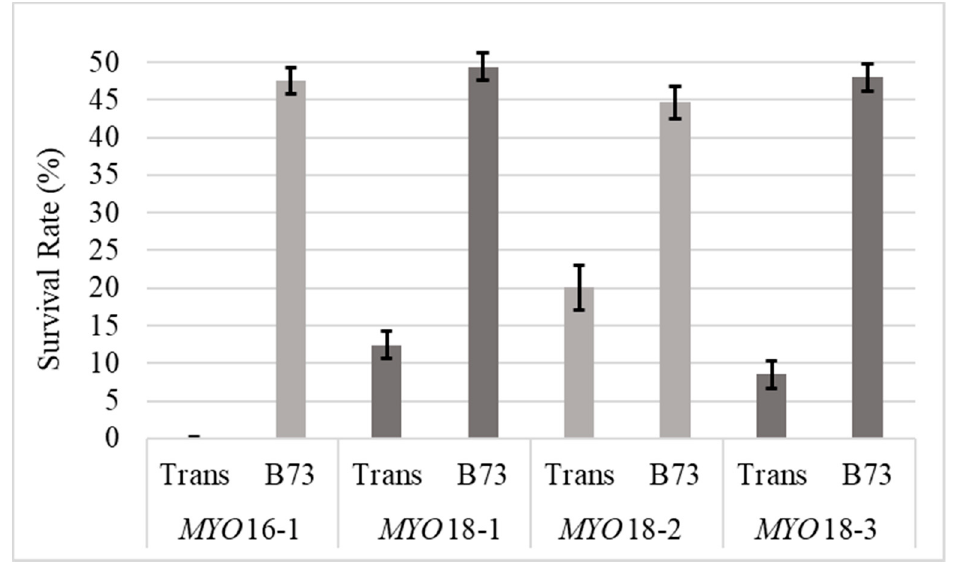
Figure 2. Survival rate of offspring when either MYO F 1 (Trans) or B73 were the male parent. All transgenic events were hemizygous for the transgene; therefore, the expected carry over would be 50%. Error bars represent standard errors.